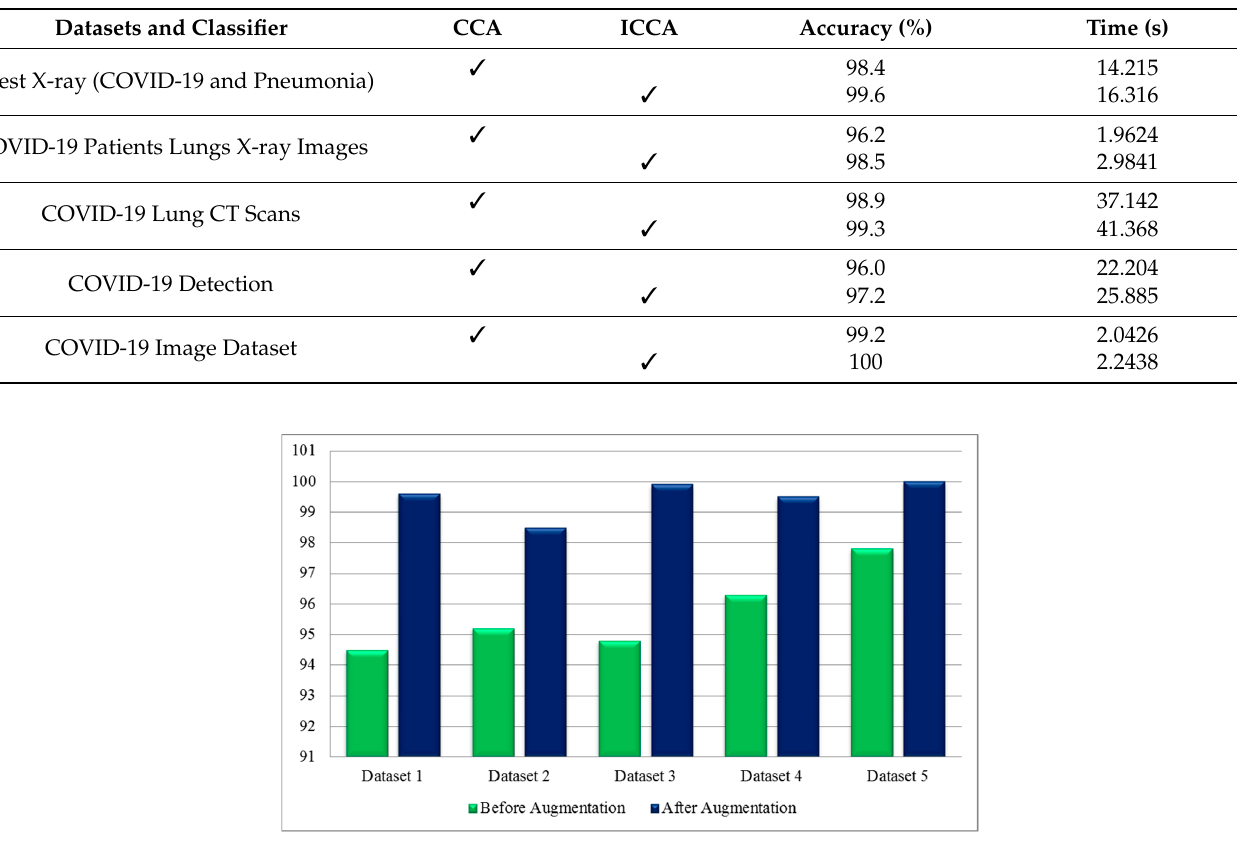
Figure 16. Classification results before and after data augmentation.